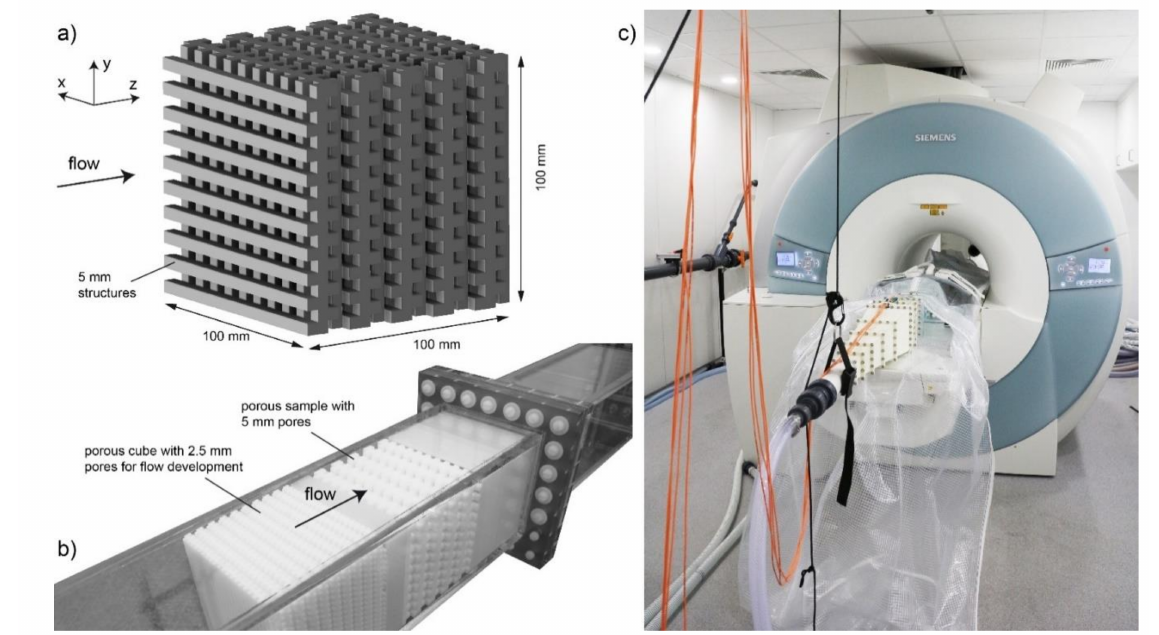
Figure 3. Description of the verification experiment: ( a ) porous sample with staggered grid similar to [19], ( b ) assembly of the flow channel, ( c ) photo taken during MRV